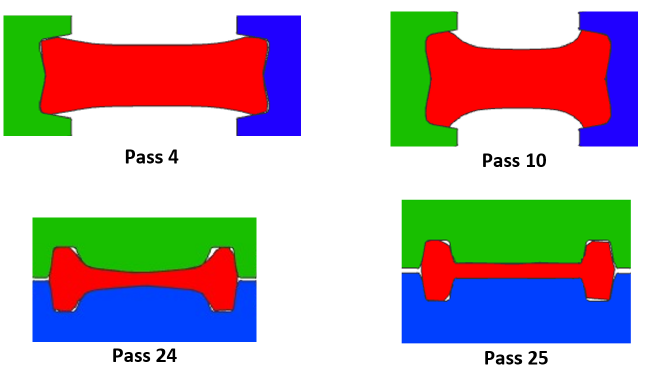
Figure 13. Central cross-section of the beam during the last pass at each groove for the simulation at real